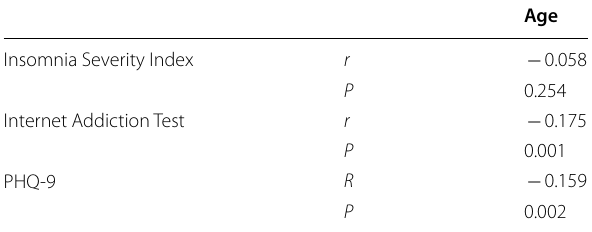
Table 6 Correlation of age with Insomnia Severity Index (ISI), Internet Addiction Test (IAT), and Patient Health Questionnaire (PHQ9)